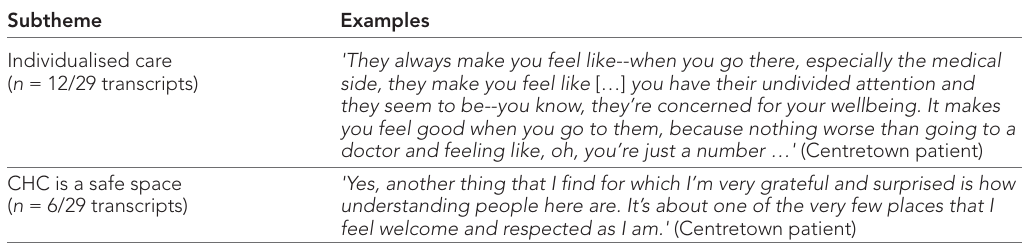
Table 2 Context subthemes with examples ( n = 18/29 transcripts) Subtheme Examples